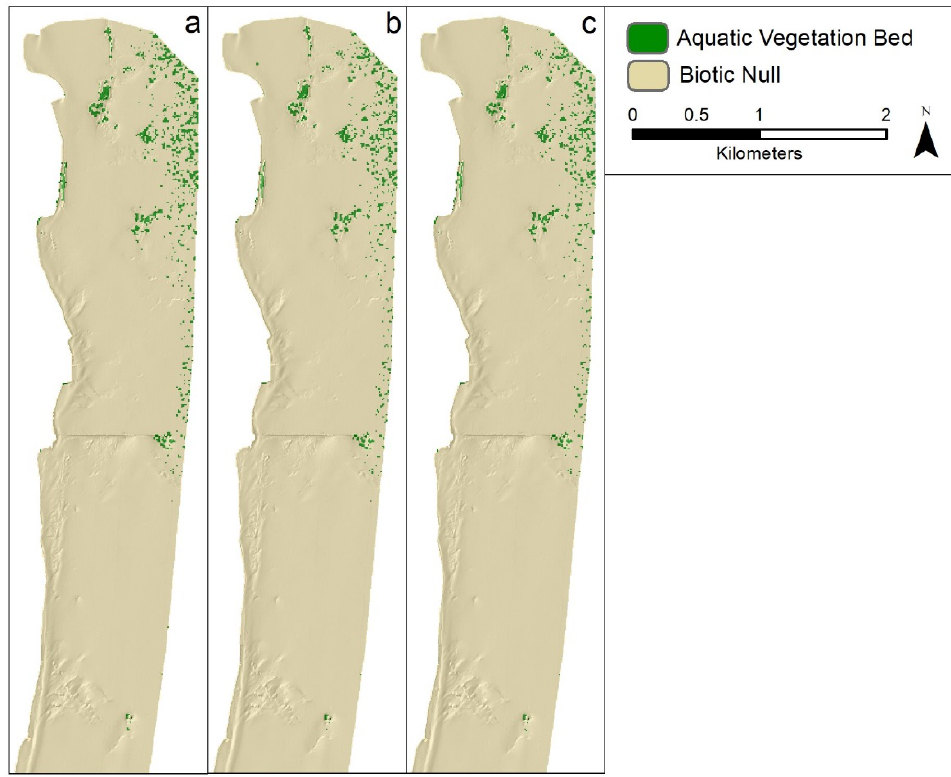
Figure 19. Tier 1 biotic component classification results using satellite data combinations for the north-central section of the study area: ( a ) S2 MS + S2 DII + S2 SDB, ( b ) S2 MS + S2 DII, and ( c ) S2 SDB + S2 DII + S2 MS.